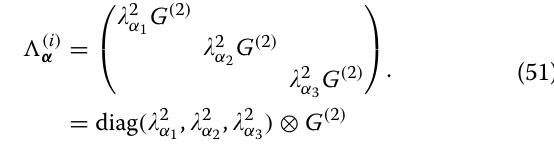
We use the same regularization parameter for each align- ment parameter α 1 , α 2 , α 3 and also for all satellites, so (cid:31) 2 = (cid:31) 2 = (cid:31) 2 that α 1 α 2 α 3 . Finally, the fluxgate calibration parameter splines are regularized in a manner similar to the alignment param- eters by minimizing their curvature, integrated over the time interval. This is equivalent to minimizing the term nal, with one block per Cryosat/DMSP instrument. Each satellite instrument has a block of the form